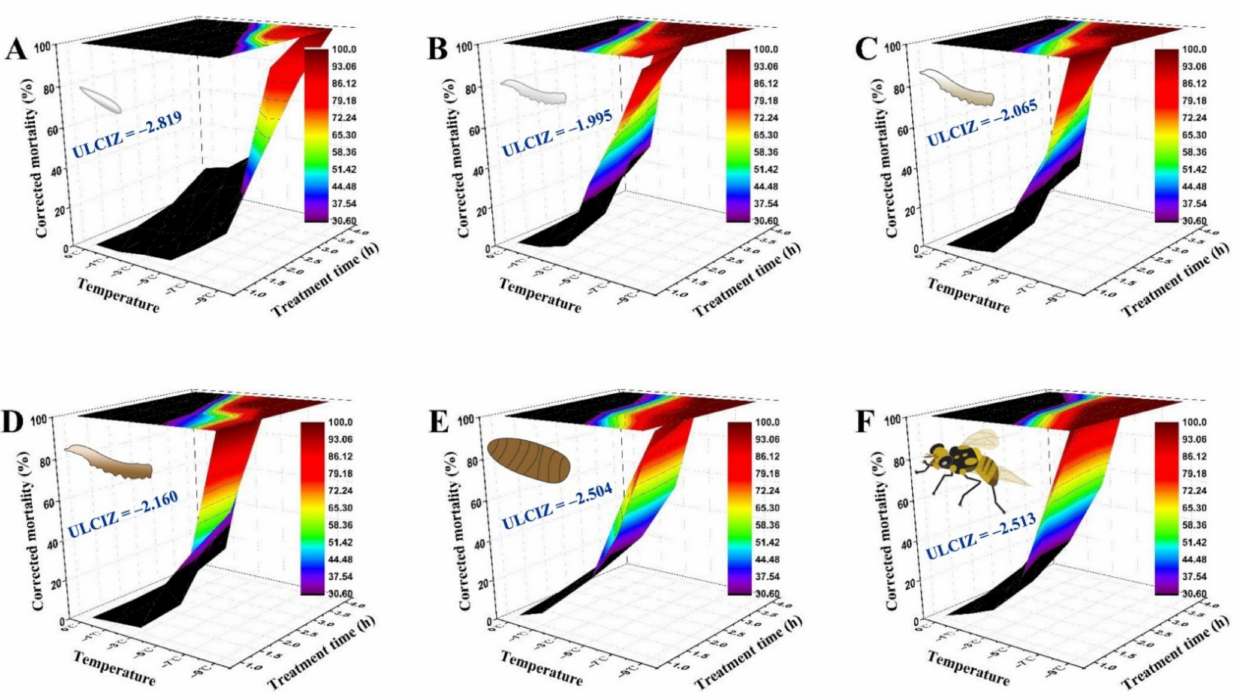
Figure 2. Three-dimensional surface models describing the relationship between exposure time, low temperature, and corrected mortality of different developmental stages of Bactrocera tau . The upper limit of the chill injury zone (ULCIZ) corresponds to the temperature that begins to cause death under continuous cold stress. ( A ) Eggs (ULCIZ = − 2.819 ◦ C), ( B ) 1st instar larvae (ULCIZ = − 1.995 ◦ C), ( C ) 2nd instar larvae (ULCIZ = − 2.065 ◦ C), ( D ) 3rd instar larvae (ULCIZ = − 2.160 ◦ C), ( E ) 1-day-old pupae (ULCIZ = − 2.504 ◦ C), and ( F ) 3-day-old adults (ULCIZ = − 2.513 ◦